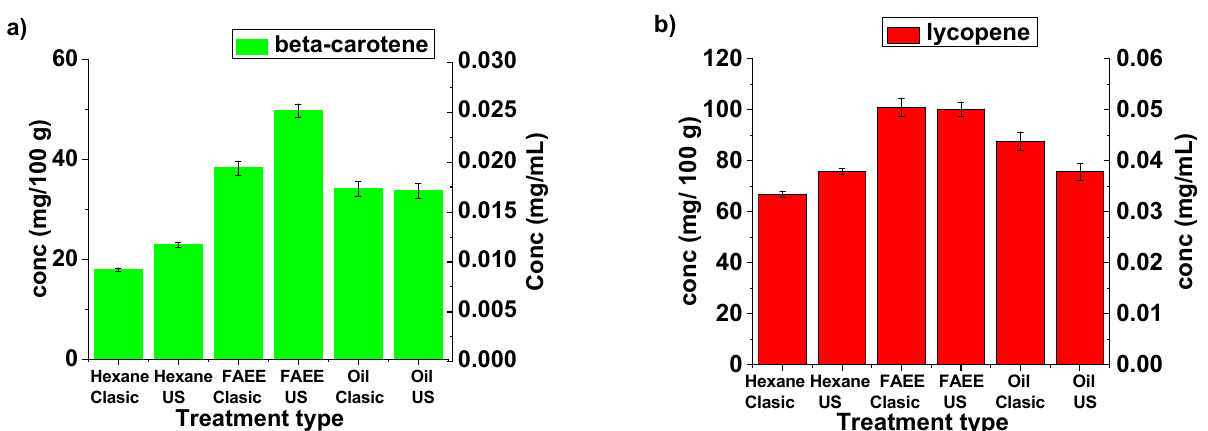
Figure 6. Changes in beta-carotene ( a ) and lycopene ( b ) concentration (mg carotenoid/100 g dry plant (left y-axis) and mg carotenoid/mL solvent (right y-axis)) induced by ultrasound after 15 min.